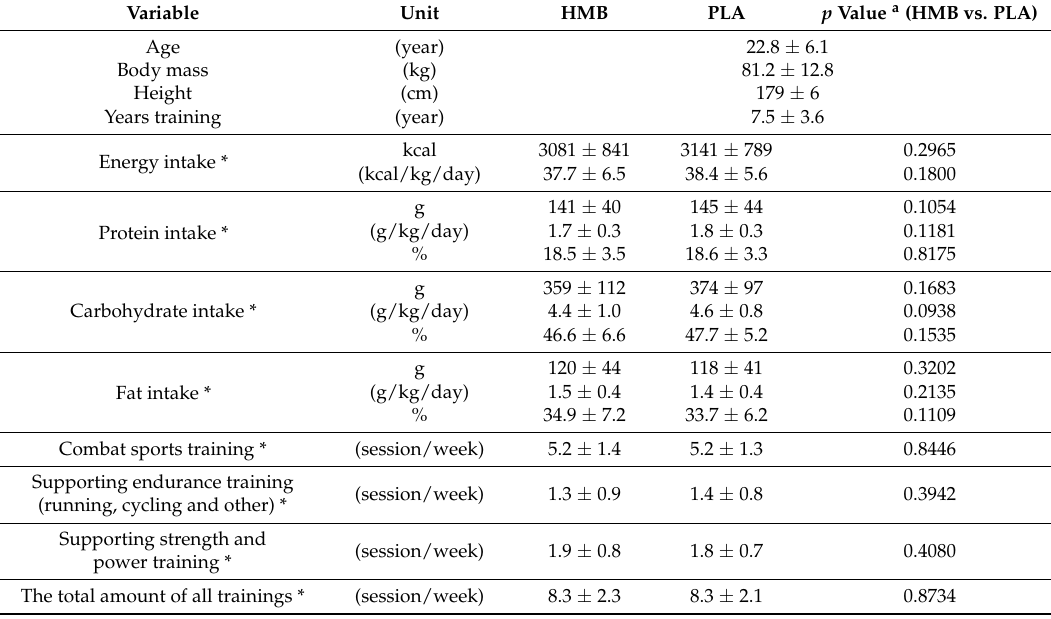
Table 1. Characteristics of the participating athletes ( N = 42